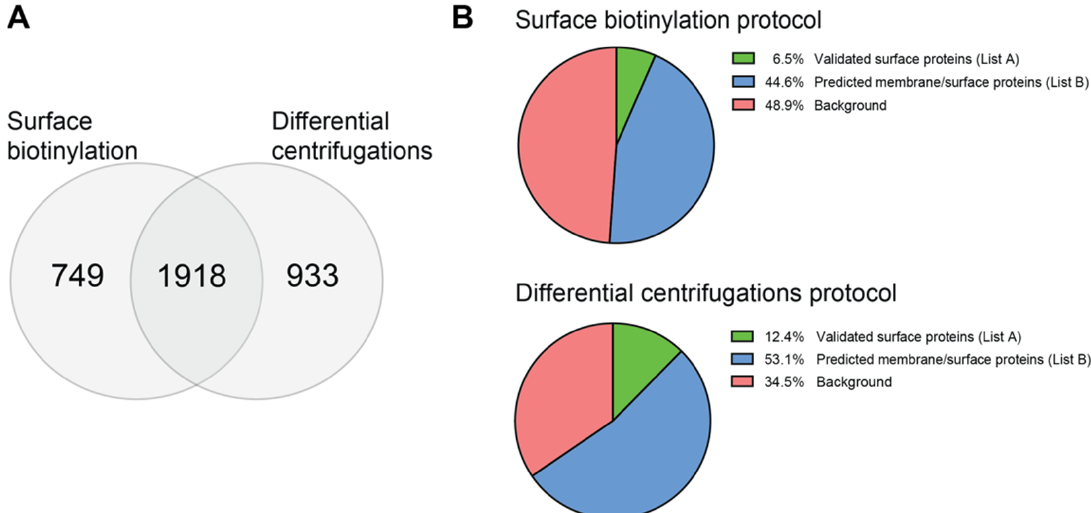
Figure 1. Comparison of surface biotinylation and differential centrifugations for the enrichment of membrane/surface proteins. Two methods for the enrichment of membrane/surface proteins were compared in a pilot experiment with the Rh4 cell line in triplicates. ( A ) More proteins were detected after differential centrifugations enrichment than after surface biotinylation, but there was a consistent overlap between the two methods. ( B ) Differential centrifugations resulted in the enrichment of a higher number of membrane/surface proteins than surface biotinylation and in a lower background of intracellular proteins. Created with Biorender.com.